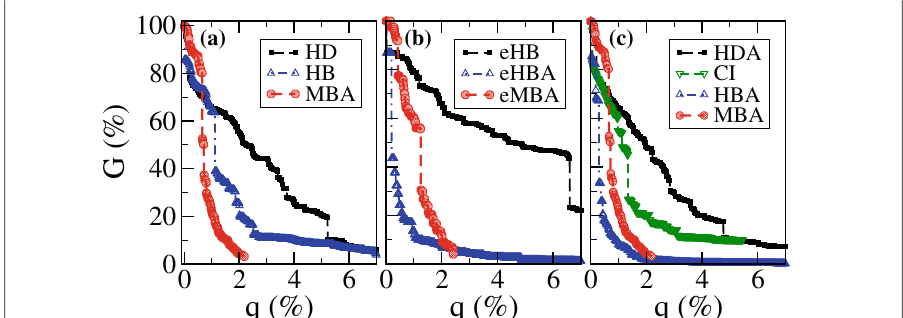
Fig. 5 Fragmentation results of the federal criminal intelligence network represented by the relative size of the largest connected component, G , as a function of the percentage of nodes/edges removed, q , according to procedures based on different measurements: a , node removal by Degree (HD - black squares), Betweenness (HB - blue triangles), and Modular (MBA - red circles); b , edge removal by Betweenness (eHB - black squares), Betweenness Adaptive (eHBA - blue triangles), and Modular (eMBA - red circles); c , node removal by Degree Adaptive (HDA - black squares), Collective Influence (CI - lower green triangles), Betweenness Adaptive (HBA - blue triangles), and Modular (MBA - red